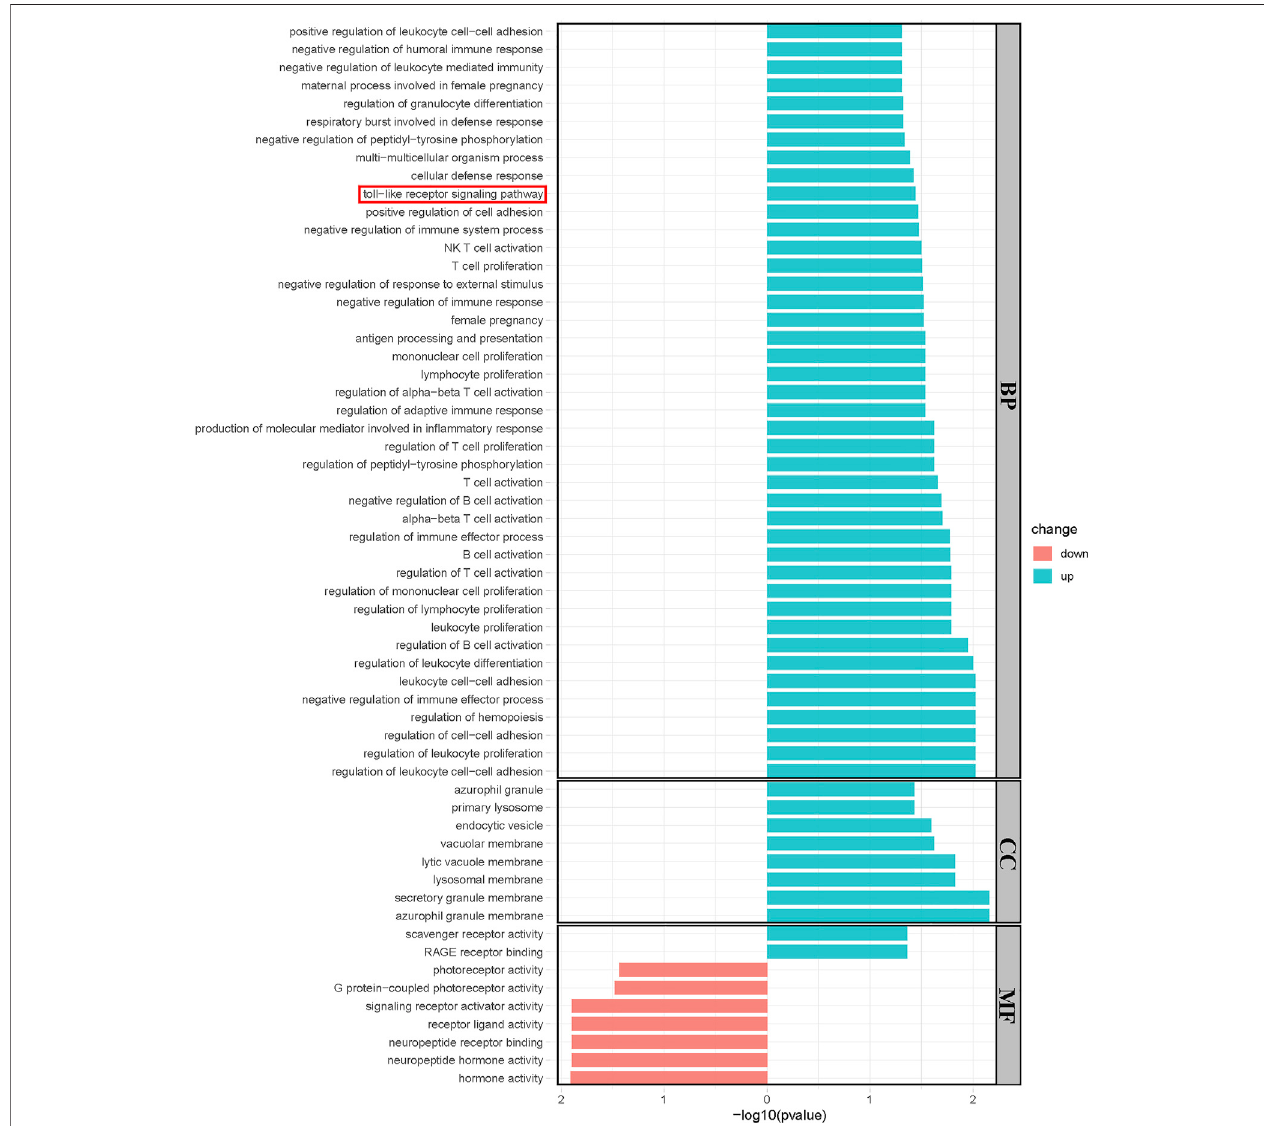
FIGURE4| ResultsoftheGenoOntology(GO)termsenrichmentanalysisofsigni fi cantDEGs.(* p < 0.05).Bluebarsshowedtheresultsofupregulatedgeneswhile red bars showed the results of downregulated genes.